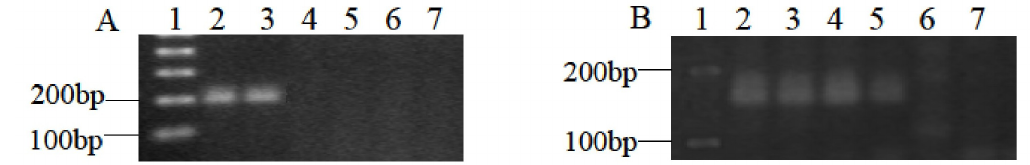
Figure 2. Amplifications of Chinese Spring and fine deletion lines. A and B showed the amplification products of gwm493 and gwm566, respectively. (1: DNA size